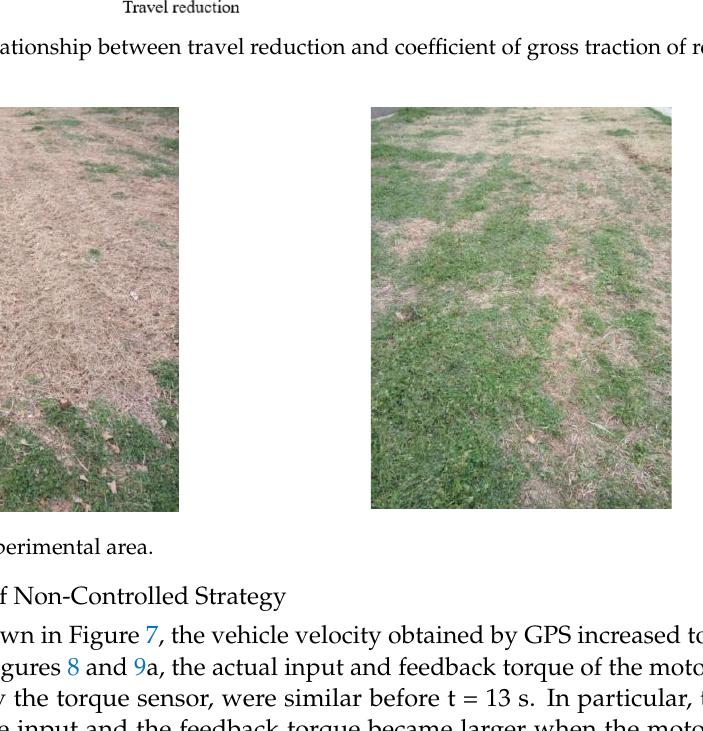
Figure 6. Experimental area.